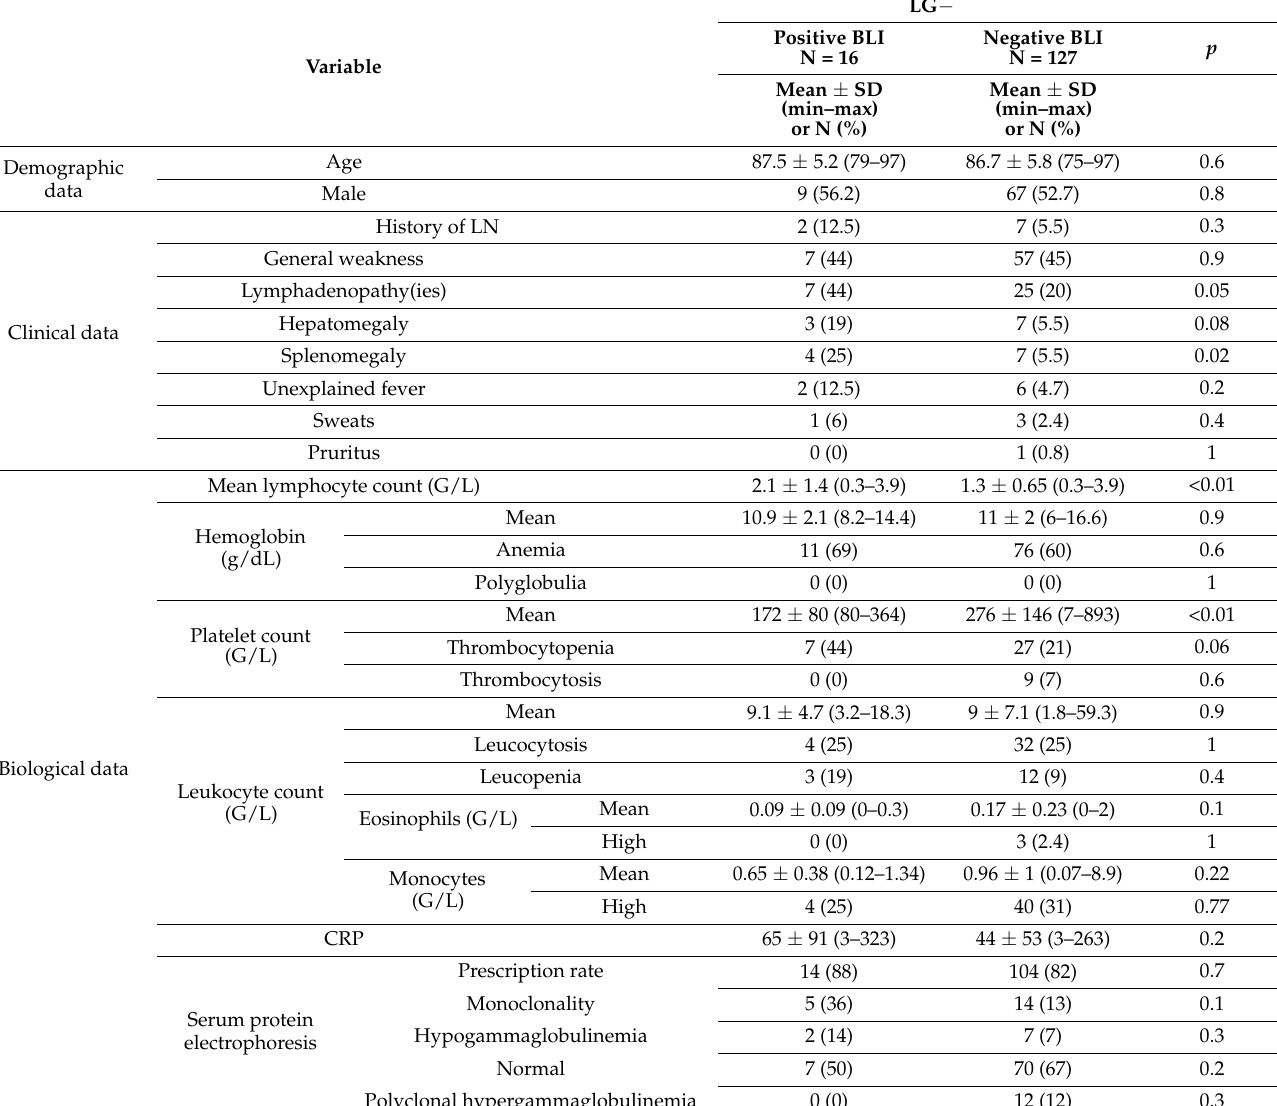
Table 3. Comparison of patients with no lymphocytosis (LG − ) according to blood lymphocyte immunophenotyping